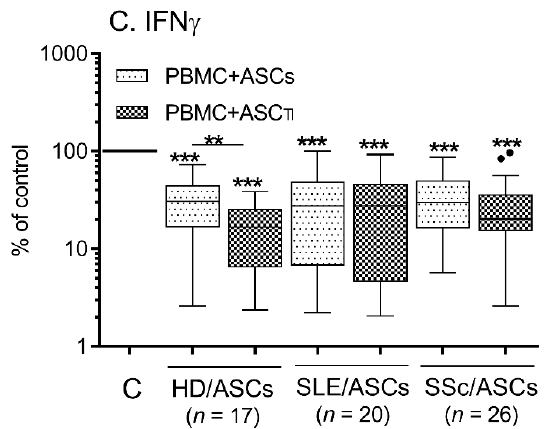
Figure 3. The effects of ASCs on the secretion of Th1 and Th2 subset-related cytokines by activated target cells. Cells were prepared and co-cultured as described in Figures 1 and 2, except that HD/ASCs ( n = 5), SLE/ASCs ( n = 16), and SSc/ASCs ( n = 14) lines were co-cultured with activated T cells ( A , B ) or activated PBMCs ( C ) that were isolated from peripheral blood of 15 and 17 healthy volunteers, respectively. The concentrations of IFN γ and IL-4 were measured in culture supernatants by specific ELISAs as described in the Materials and methods. Results are expressed as the percentage of the cytokine levels regarding those found in separately cultured activated control target cells ( C ) and are shown as the Tukey’s boxes; n—the number of experiments performed. * p = 0.05–0.01; ** p = 0.01–0.001; *** p = 0.001–0.0001 for intra-group comparison; the inter-group differences were statistically insignificant.